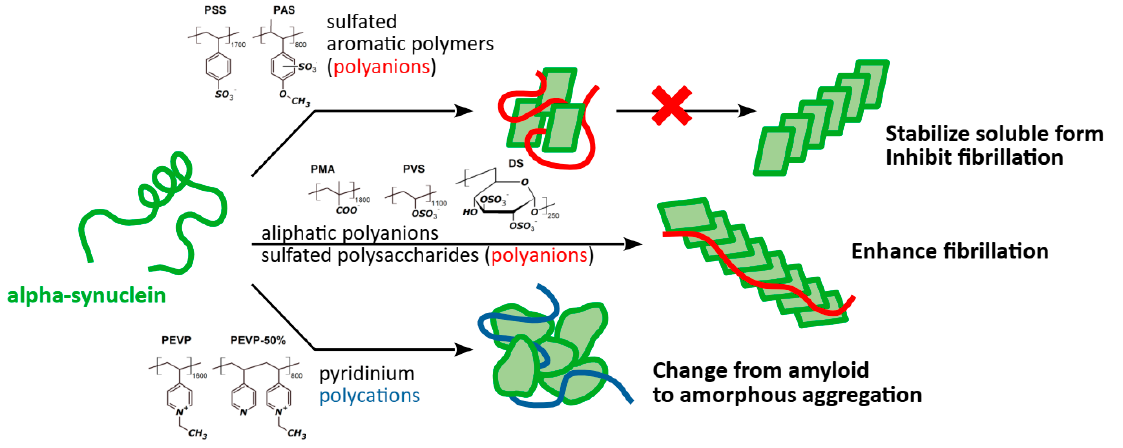
Scheme 2. Schematic summary of influence of the tested polymers on amyloid aggregation of alpha-